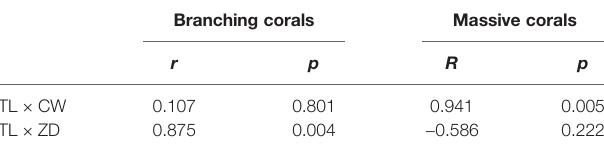
TABLE 3 | Correlations of total lipid content (TL) of massive and branching corals with corallite area (CA) and Symbiodiniaceae density (SD). Branching